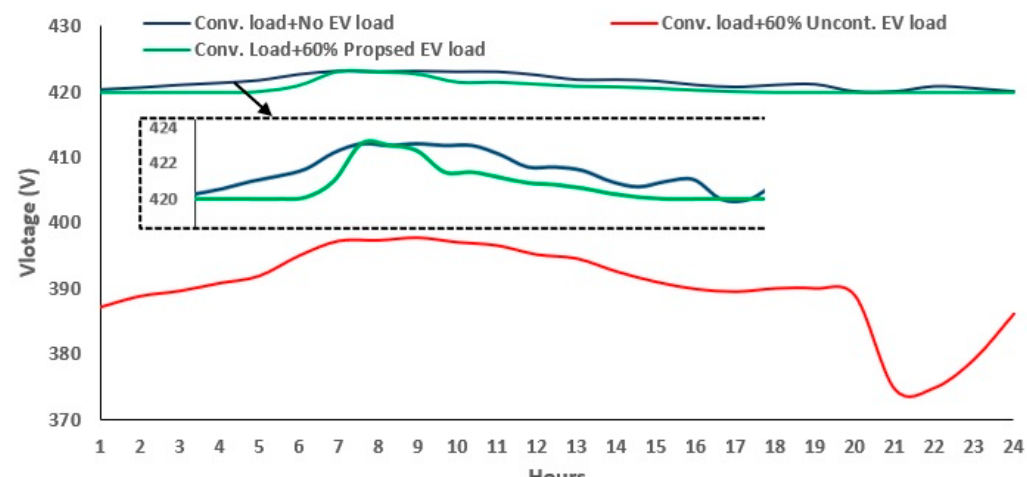
Figure 19. Load profiles of Transformer 740/feeder 1 in summer at 60% EVC with/without response to the critical hours.